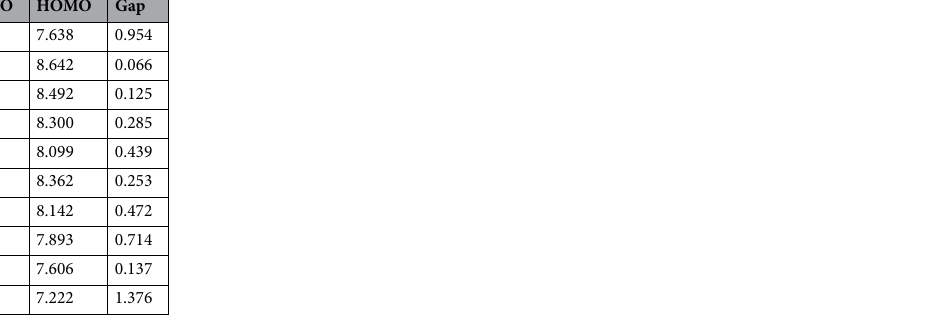
Table 3. The LUMO (eV), HOMO (eV)level, and the bandgap (eV) in each M@Ce 12 O 836+ cluster model based on the reference level as the vacuum